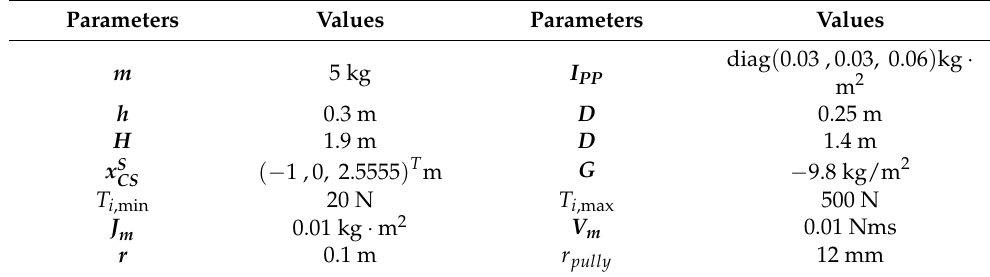
Table 2. System simulation parameters.